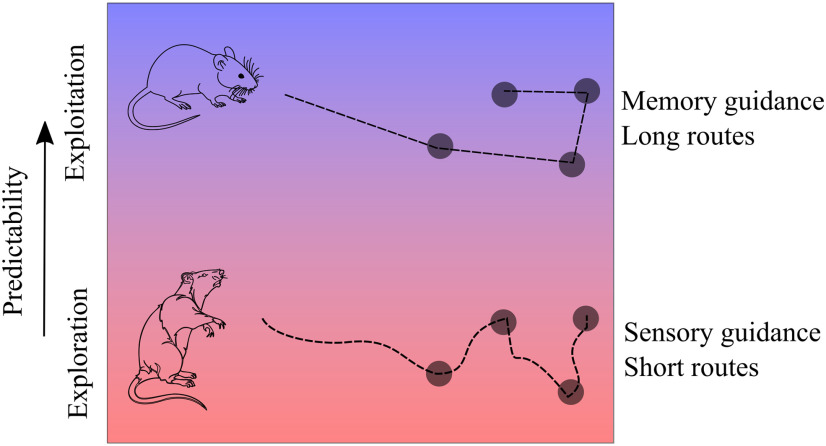
Schematic of two strategies selected to solve the probabilistic traveling salesman task. A schematic of the main results, showing that animals adaptively change the strategies used for a search depending on the level of uncertainty of the environment, here depicted as a spectrum from red (uncertain) to blue (predictable).